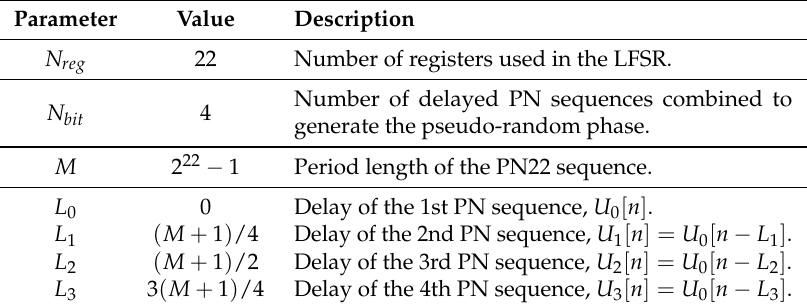
Table 2. Main parameters used in the generation of the sequence